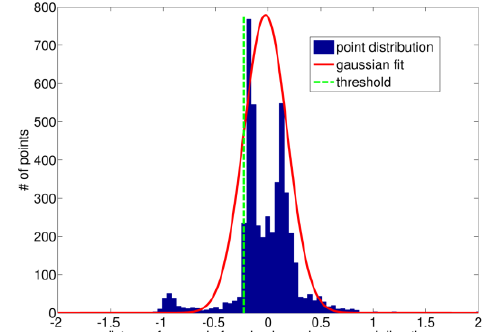
Figure 4. Example for a histogram of the point distribution along the normal direction of the façade, the red line is the fitted Gaussian function and the dashed line is the derived threshold to decide which points are indoor points.